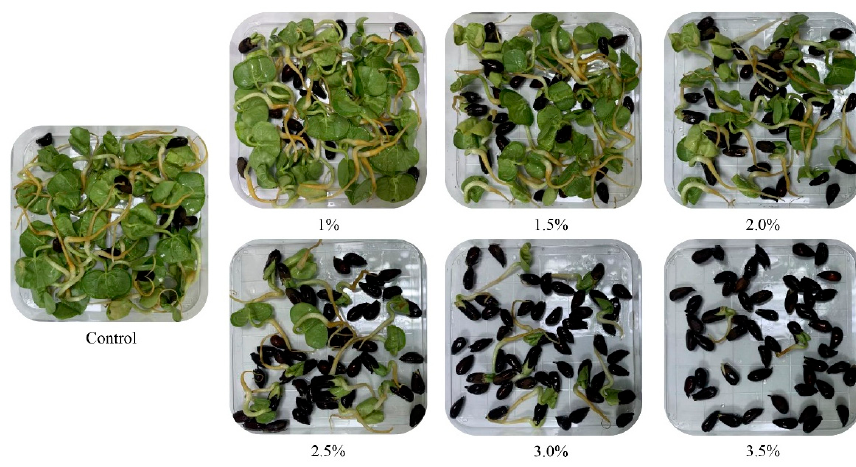
Figure 2. Germination rate of ISR seeds under different concentrations of EMS.